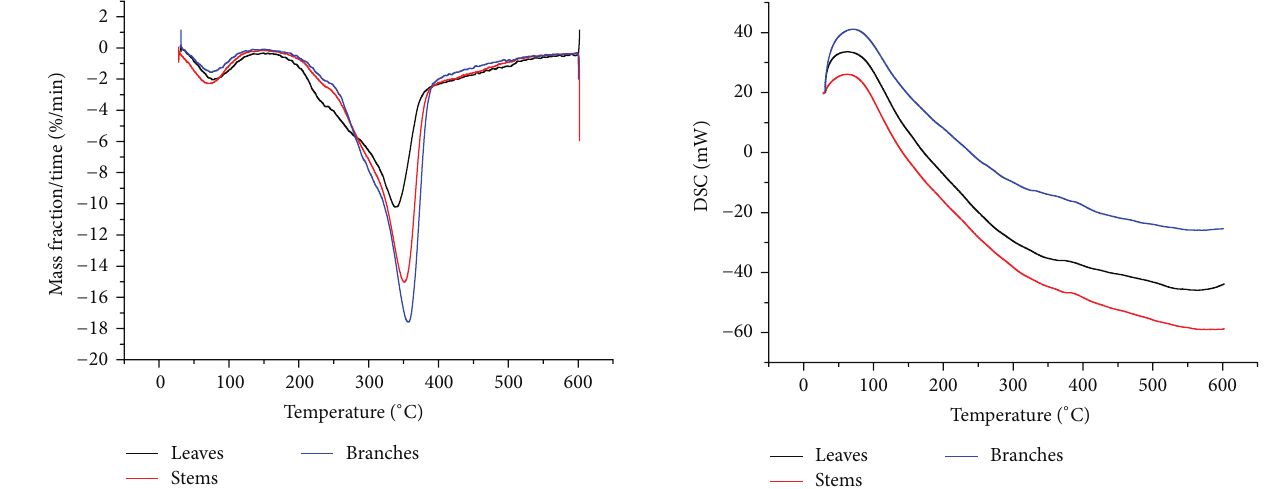
Figure 3: DSC curves for the three types of willow